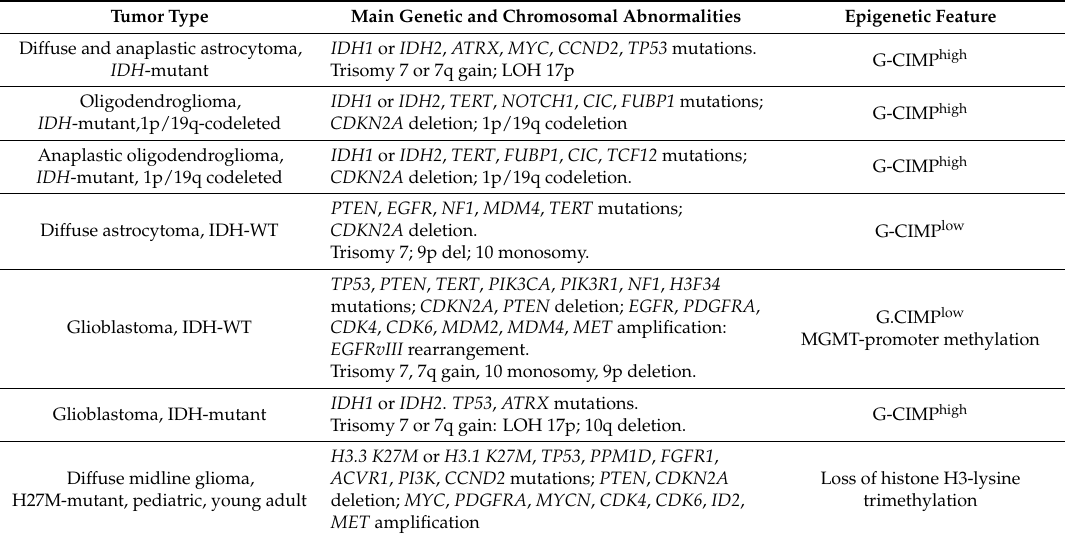
Table 2. Main genetic, epigenetic, and chromosomal abnormalities of diffuse glioma